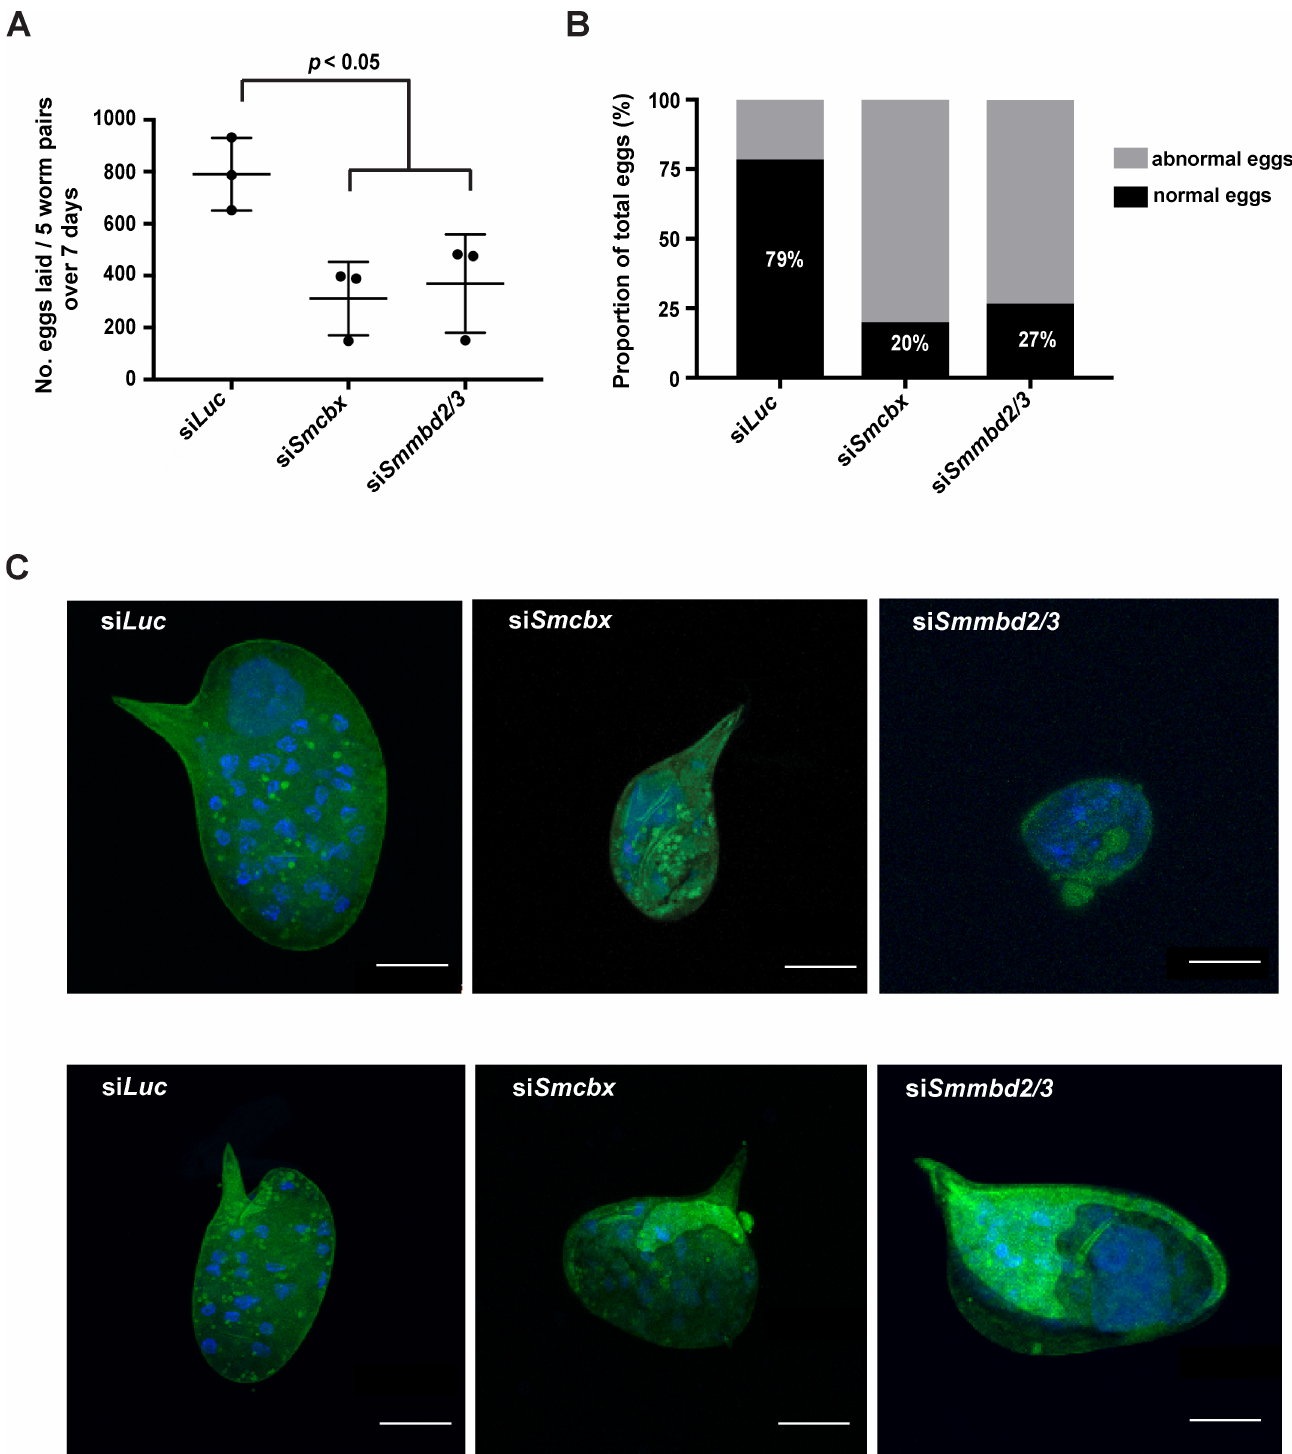
Fig 7. SmMBD2/3 and SmCBX are both required for schistosome oviposition. (A) Seven-week old adult male and female schistosome pairs were electroporated with 5 μg siRNA duplexes targeting luciferase (si Luc ), Smcbx (si Smcbx ) or Smmbd2/3 (si Smmbd2/3 ). At day 7 post treatment, eggs were collected from wells (5 worm pairs/well; n = 3) and counted. A one-way ANOVA followed by Tukey HSD test was performed to identify statistically significant treatments. (B) Percentage of eggs (n = 14 for si Luc , n = 20 for si Smcbx , n = 15 for si Smmbd2/3 ) demonstrating abnormal (grey) versus normal (black) phenotypes. Normal = oval eggs with lateral spine, containing regular surface autofluorescence. (C) Representative fluorescent images of eggs collected from wells of si Luc , si Smcbx and si Smmbd2/3 treated worm pairs. Green = eggshell autofluorescence; blue = DAPI + cells. Bar = 20 μm. https://doi.org/10.1371/journal.ppat.1007107.g007 PLOS Pathogens| https://doi.org/10.1371/journal.ppat.1007107 June 28,